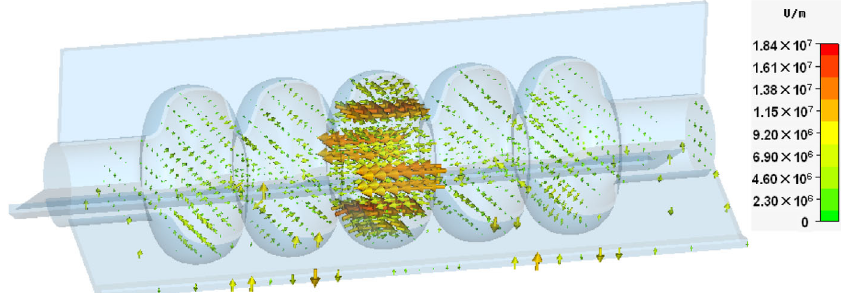
FIG. 6. (Color) E -field of a quadrupole mode with the highest R=Q (cid:3) Q e =f in the slotted cavity. Frequency ¼ 2 : 632 44 GHz , Q e ¼ 379 : 2 , R=Q ¼ 2 : 84 (cid:5) 10 (cid:1) 2 (cid:1) = cm 4 . The electric field is derived by assuming 1-J stored energy of this quadrupole mode in the